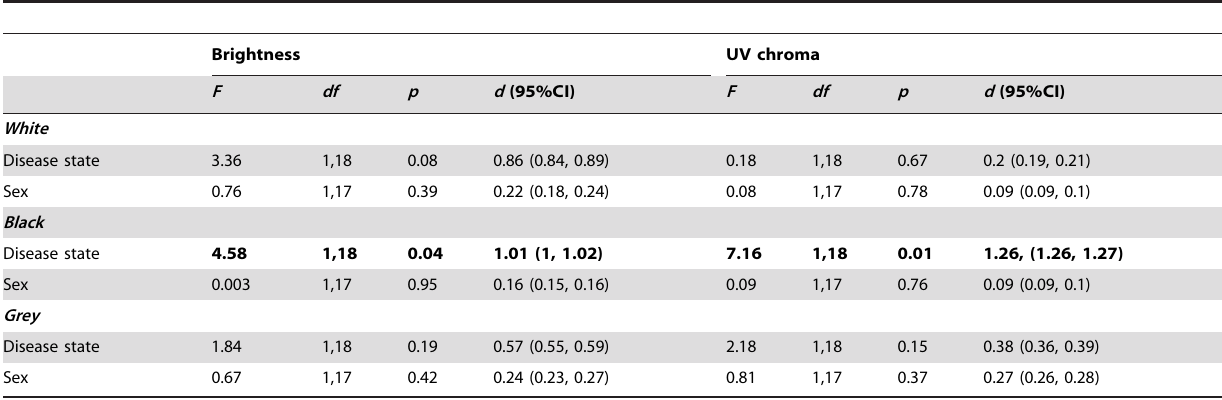
Table 2. GLM showing effects of disease state (affected versus unaffected by avian keratin disorder) and sex on color variables of white, black and grey feathers of black-capped chickadees after removal of dirt through wash